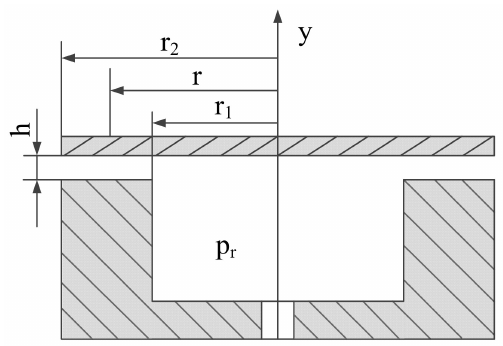
Figure 6. Sketch of the pair of